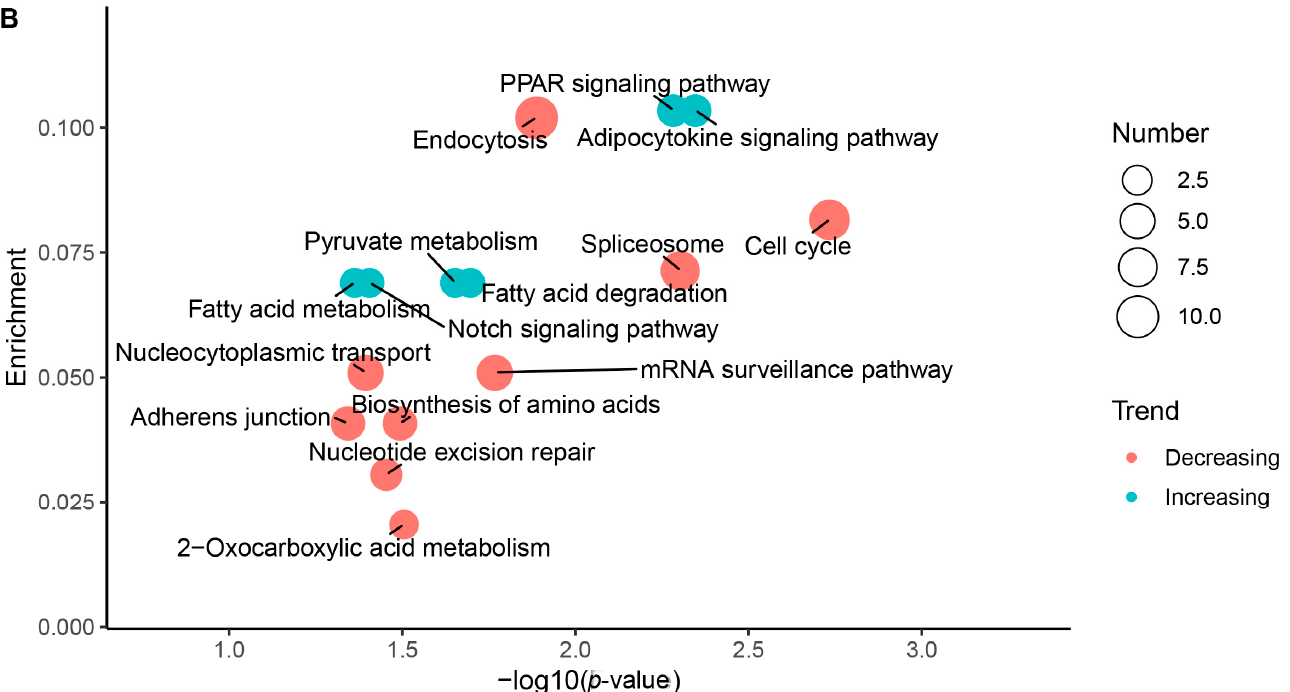
Figure 4. Trend and function enrichment analysis of mRNAs in the ceRNA network: ( A ) trend analysis of mRNAs in the ceRNA network using STEM. The significantly enriched profiles are purple, green, and red colored ( p < 0.05). Colors represent the categories clustered by gene profiles; ( B ) scatter plot of significantly enriched KEGG pathways of mRNAs in the increasing and decreasing profiles. The node size is proportional to the gene number. Red and turquoise represent pathways of decreasing and increasing profiles, respectively.